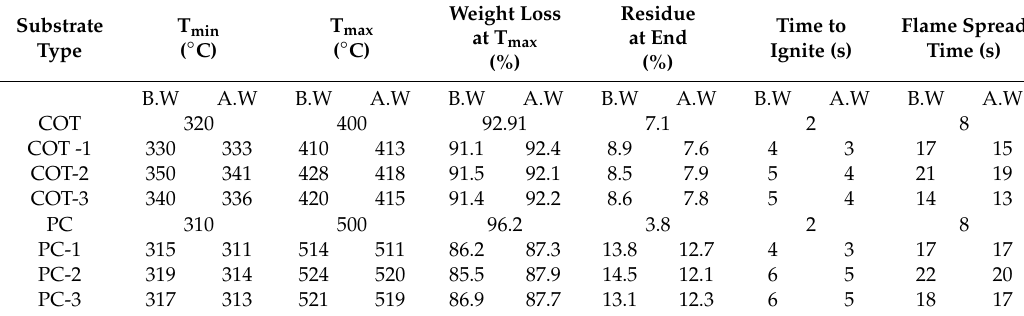
Table 3. Stability of untreated and treated cotton (COT) and PC blend